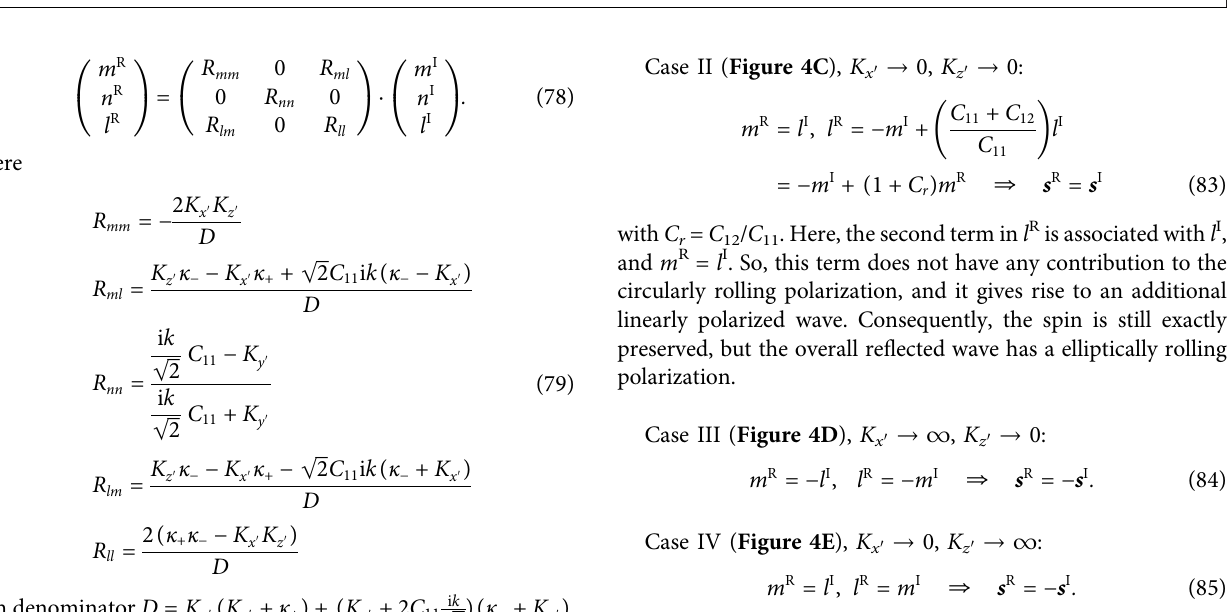
FIGURE6| Intheobliquere fl ectionat45 ° ,ellipticallyrollingpolarizationsofthere fl ectedwavesfromthefreeboundarymayappearduetodifferentmaterialstiffness constants C 11 and C 12 . An incident spin which is the same of that shown (A) is assumed throughout. (A) also represents the purely circularly rolling polarization for C r (cid:2) − 1. (B – F) showtheellipticallyrollingpolarizationsforthecasesof C of clearly demonstrating differences in elliptical